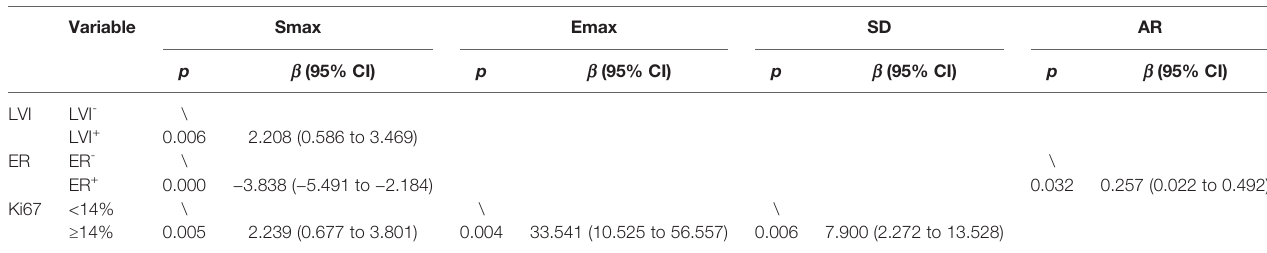
TABLE 4 | Multivariate linear regression analysis for clinicopathological